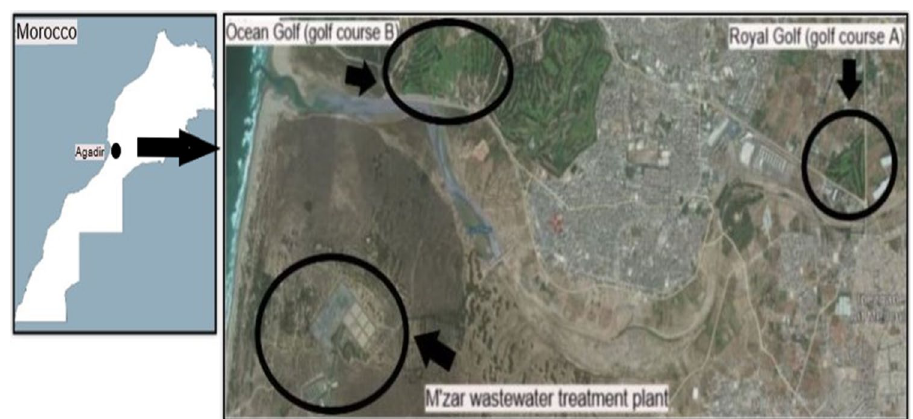
Fig. 1 Map of the